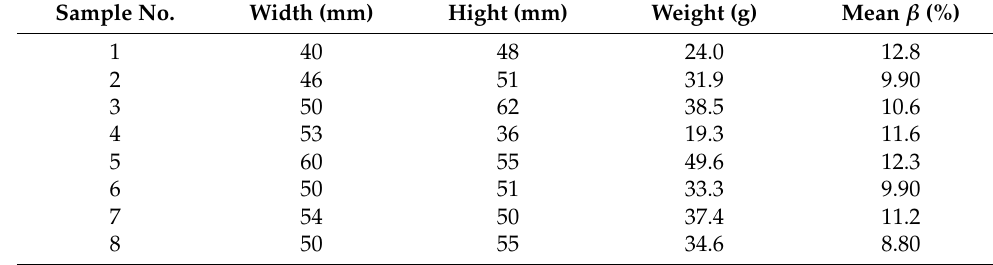
Table 3. Strawberry quality parameters on 20 February 2021.